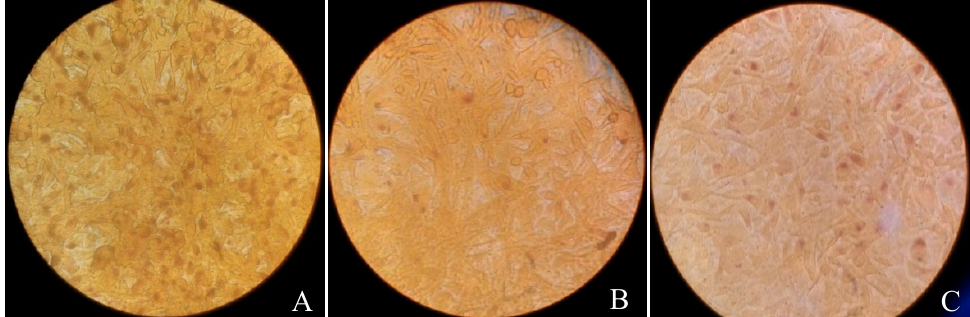
Figure 2. The inclusions viewed under the microscope (×200) by iodine dye. The inclusions are stained dark brown and positioned decentered in the cells, whereas the normal cells are light-stained or